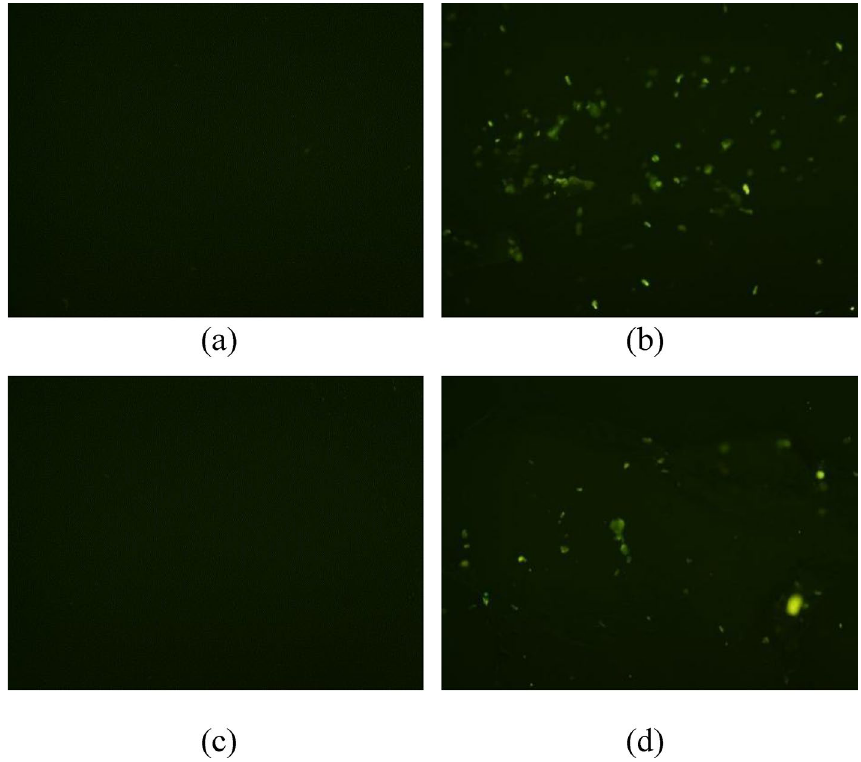
Figure 7. Deposition of fluorescent particles on the flushing button and lavatory door handle after flushing of the toilet: ( a ) on the flushing button without addition of fluorescent powder to the cistern, ( b ) on the flushing button after addition of fluorescent powder to the cistern, ( c ) on the door handle without addition of fluorescent powder to the cistern, (d) on the door handle after addition of fluorescent powder to the